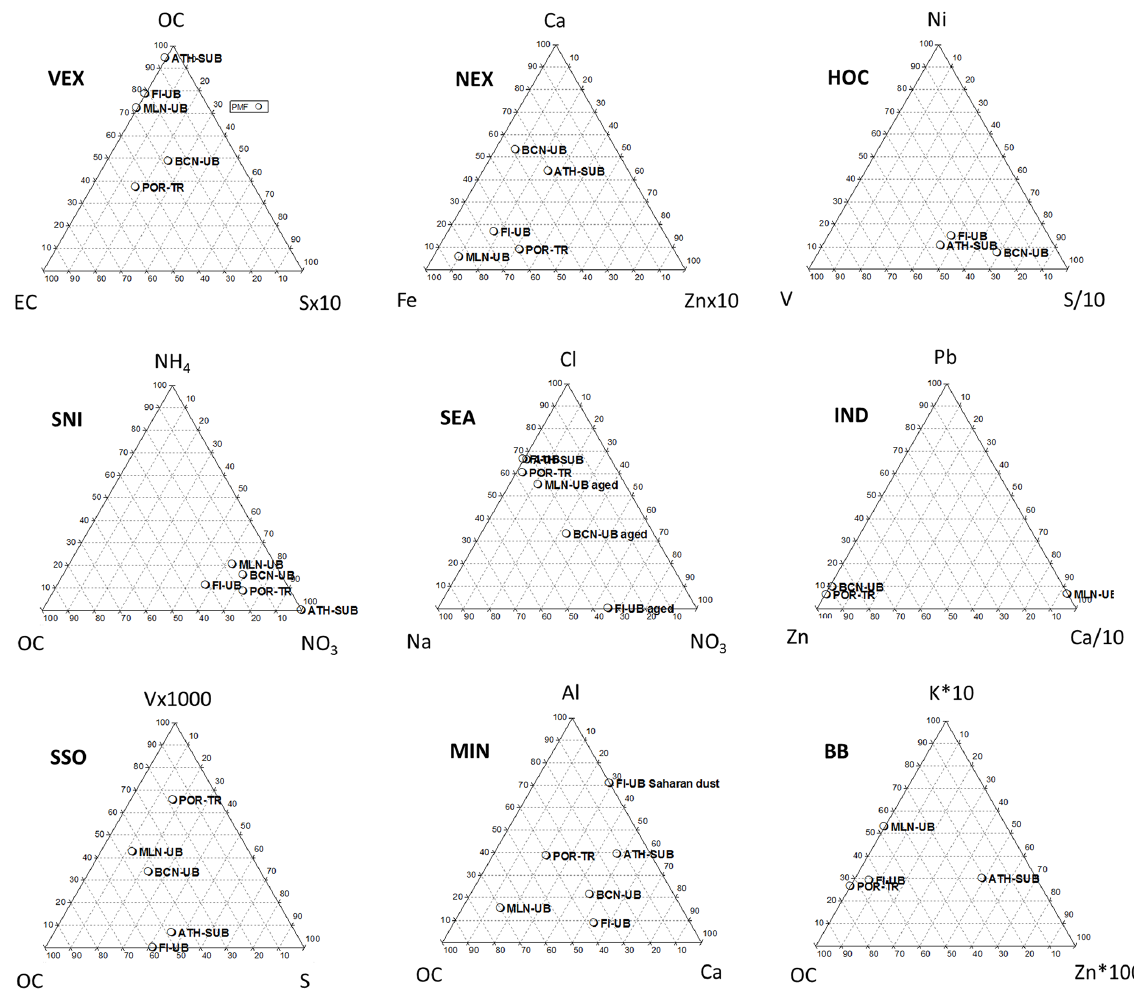
Figure 4. Ternary plots for PMF factor